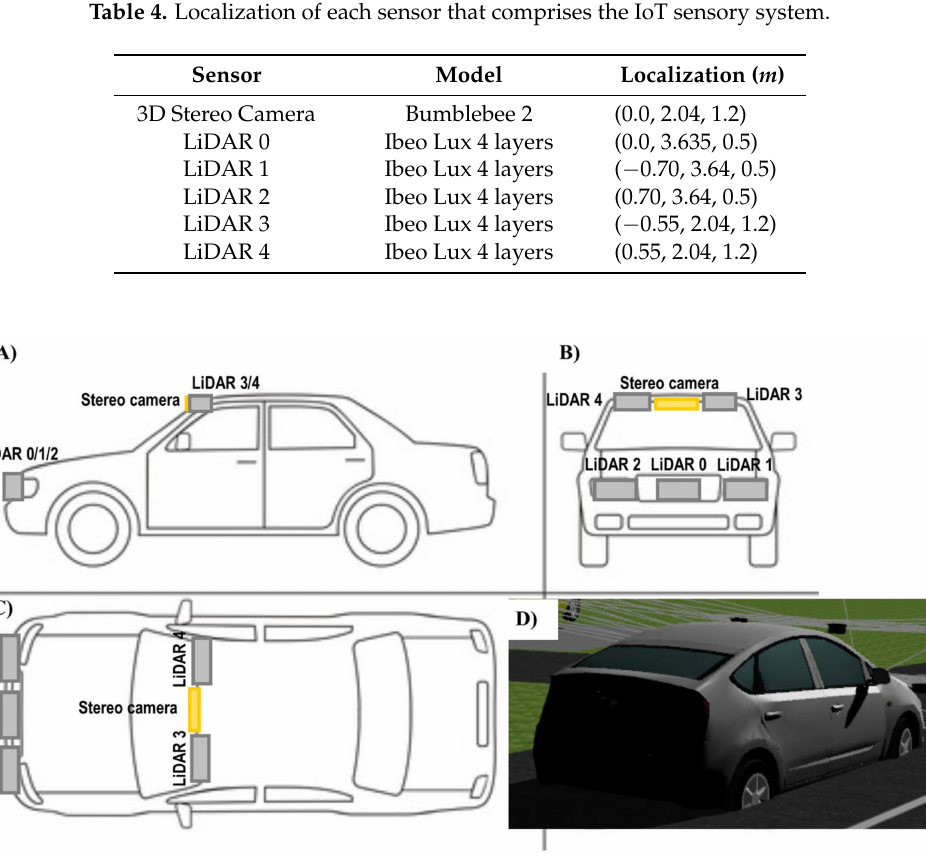
Figure 6. Side ( a ); front ( b ); plan ( c ) and rear view ( d ) of on-board IoT sensory system setup in a vehicle